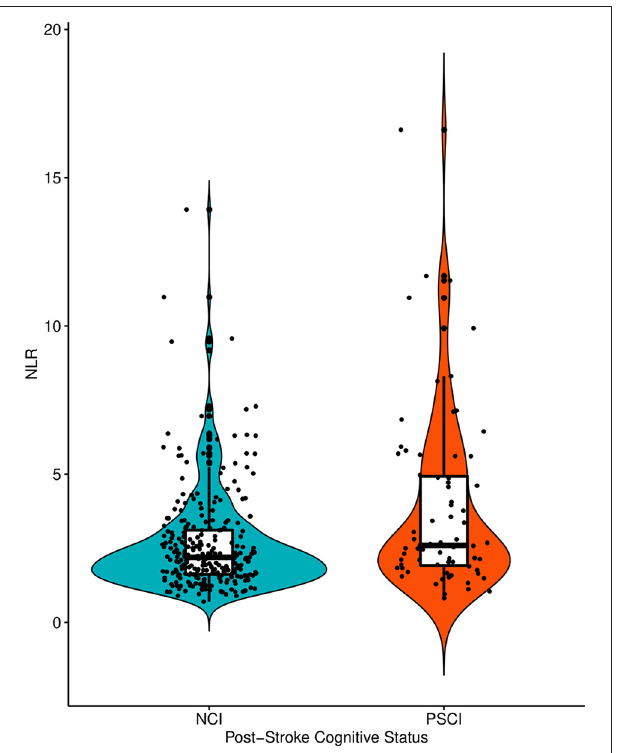
FIGURE 2 | The violin plots demonstrating the differences in the distribution of the NLR levels between NCI and PSCI groups. NLR, Neutrophil-Lymphocyte Ratio; NCI, No Cognitive Impairment; PSCI, Post-Stroke Cognitive Impairment.